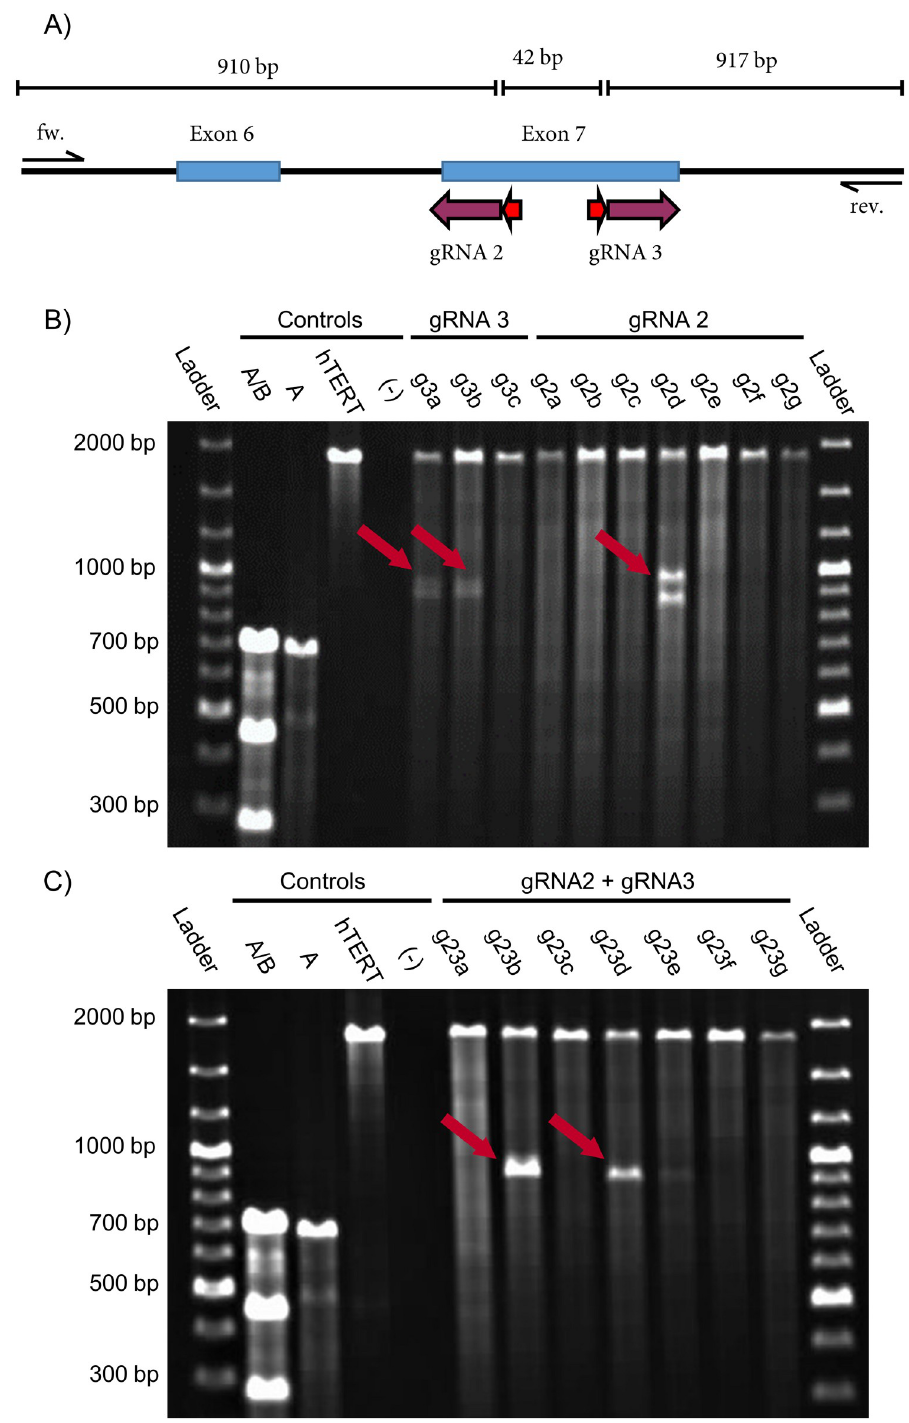
Fig 4. Screening for indel mutations in genetically modified hTERT MSCs by the Surveyor assay. (A) Exons 6 and 7 (blue boxes) from TNFSF11 with target sites of the corresponding gRNAs (purple arrow). PAM sequences are indicated by red arrows. (B) Agarose gel image (1%) lines are of pNV-RANKL/KO-gRNA2 and pNV-RANKL/KO- gRNA3 transfected hTERT MSCs clones. The clones g3a, g3b, and g2d show indel mutations indicated by the red arrows. (C) Agarose gel image of pNV-RANKL/KO-gRNA2 and pNV-RANKL/KO-gRNA3 co-transfected hTERT MSCs clones where clones g23b and g23d show a deletion (red arrows). Controls used: mixed A/B (positive control), pure A (negative control—controls A and B from the kit), unmodified hTERT MSC DNA (hTERT), a template-free negative control (-).